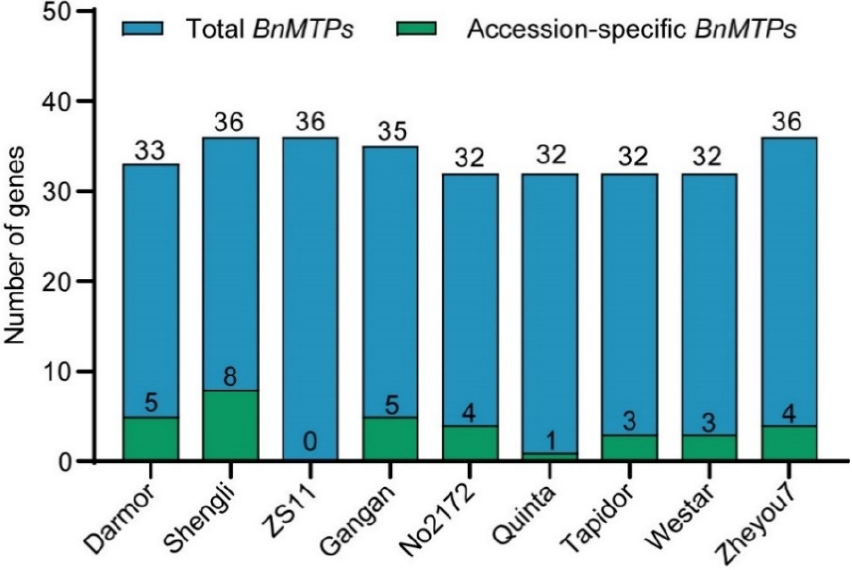
Figure 7. The number of BnMTP genes in different rapeseed accessions. The blue column represents the total BnMTPs and the green column represents the accession-specific BnMTPs .